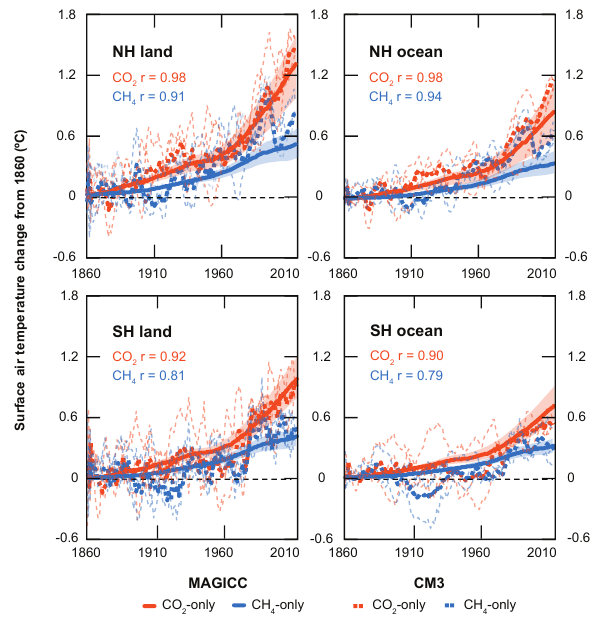
Figure 7. Regional surface air temperature responses in degrees Celsius ( ◦ C) for CM3 (dashed line) and MAGICC (solid line) model indirect simulations – CO 2 -only (orange) and methane-only (blue). Individual initial condition-driven ensemble members for CM3 runs shown in thin dashed lines. Range for MAGICC physics-driven en- semble members shown in shaded colours. CM3 data are 5-year running means. Correlation coefficient between MAGICC and CM3 temperature responses are also